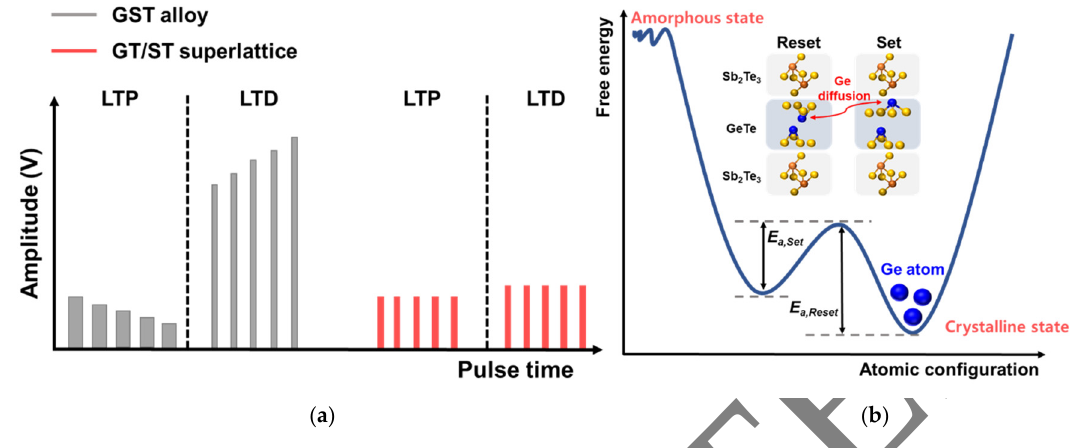
Figure 3. ( a ) Pulse scheme for long-term potentiation (LTP)/long-term depression (LTD) considering the mechanism of the GST alloy and GT/ST iPCM. ( b ) Schematic of the potential for Ge atoms of iPCM to diffuse in the reset and set states. The Ge atoms are shown in blue, Te atoms in yellow, and Sb atoms in orange.